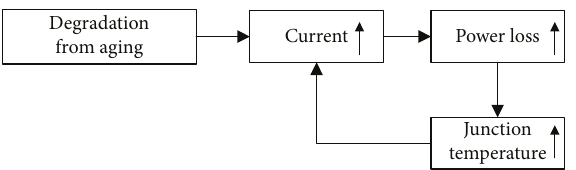
Figure 16: The positive feedback loop of power module degradation.